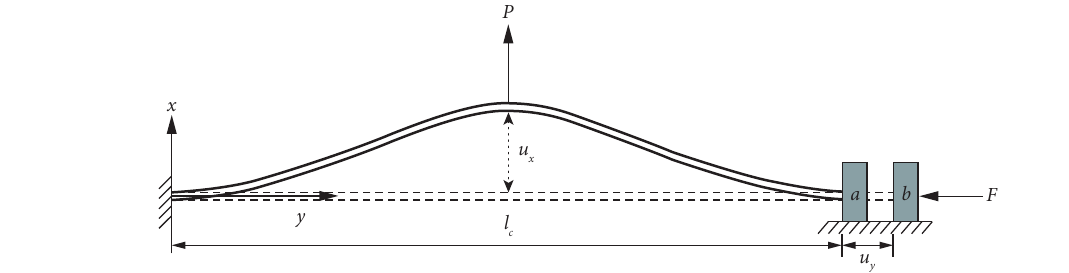
Figure 2: Te buckled beam with